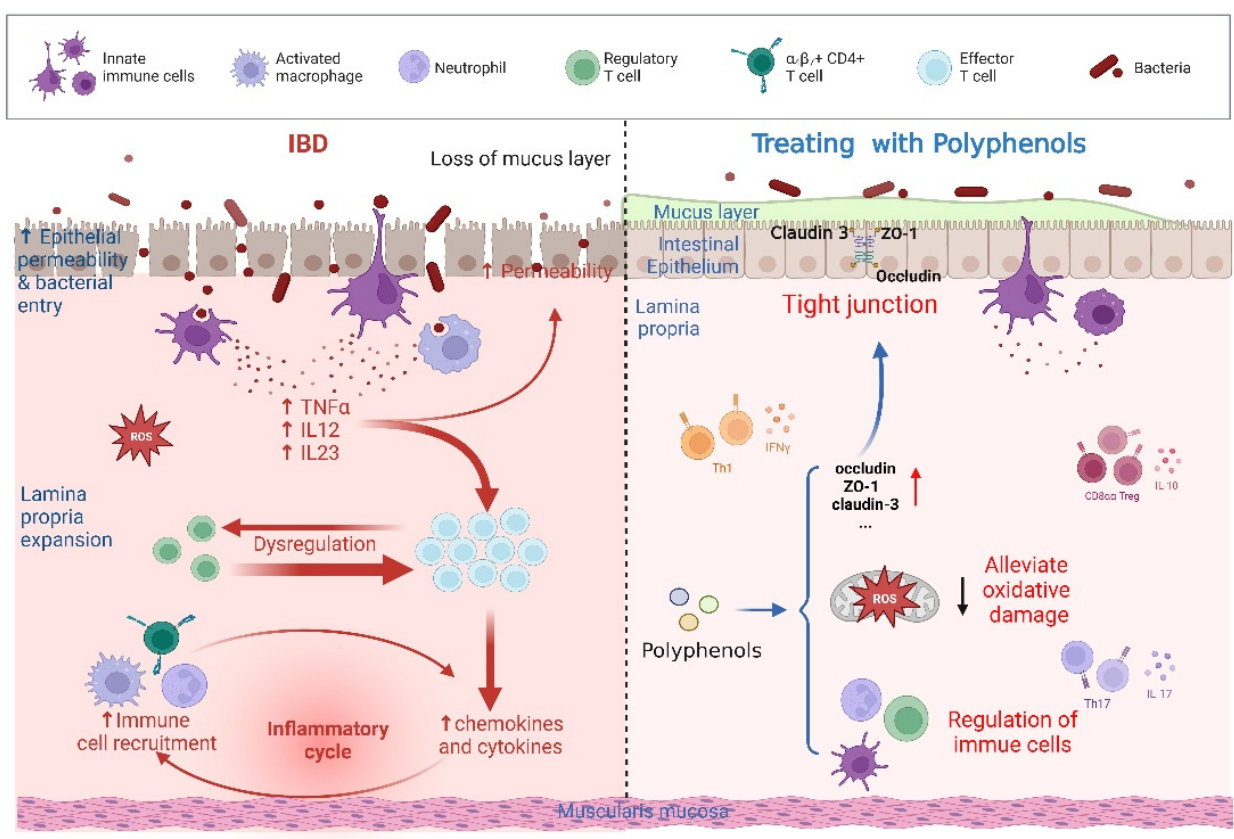
Figure 3 . Polyphenols retard inflammation and restore redox homeostasis of the gut by regulating microbiota. Polyphenol intervention increases the diversity of gut microbiota, which is essential for maintaining the intensity of the intestinal mucosal barrier, thus promoting the antioxidative defense through activating Nrf2, elevating the content of SOD and GSH, and weakening the activity of NF- κ B. In this process, the gut microbiota metabolite SCFAs assist differentiation of Treg cells, counteracting excessive inflammation caused by activation of effector T cells.